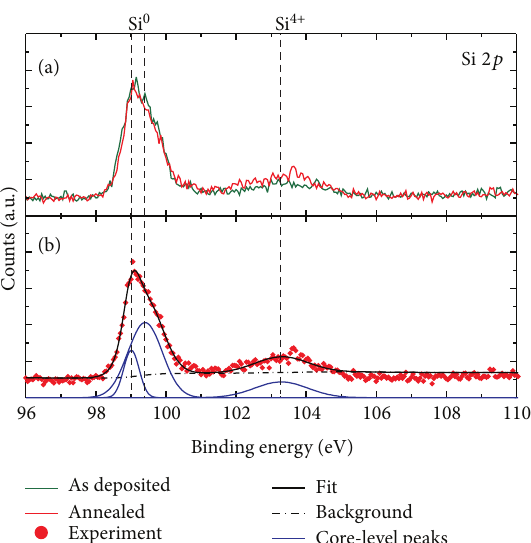
aluminum oxide at 1000W and aer a 30min postannealing at